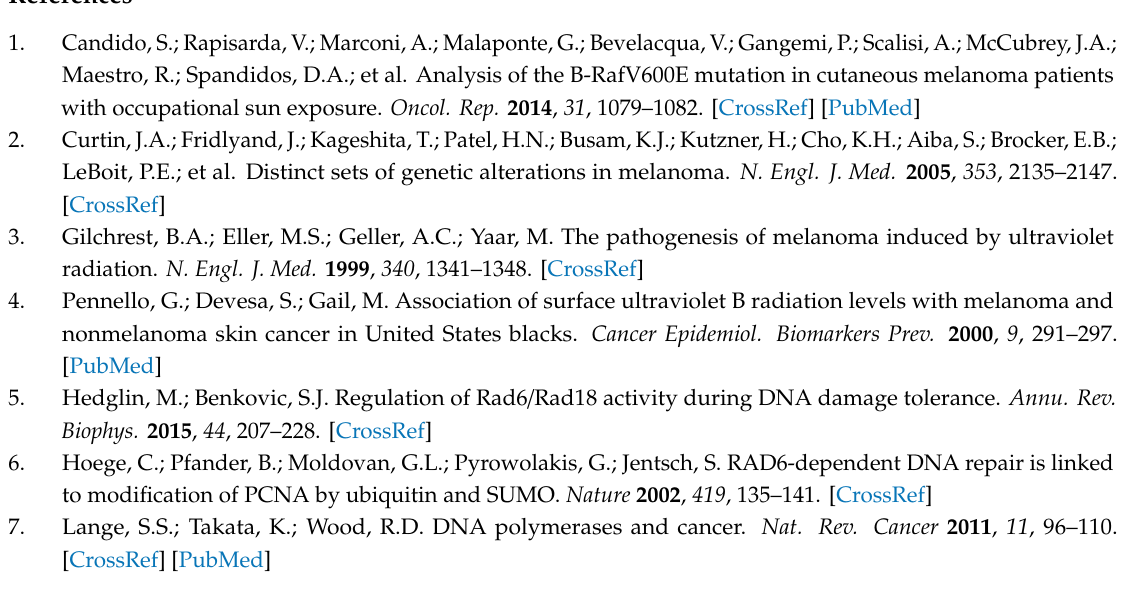
Figure S1: Analysis of MG132 e ff ects on wild-type (WT), RAD6Bintron5ins, and RAD6B ∆ exon4 protein levels. Table S1: Whole exome sequence analysis of RAD6A (UBE2A) transcripts in patient-derived melanoma xenografts. Table S2: Whole exome sequence analysis of RAD6B (UBE2B) transcripts in patient-derived melanoma